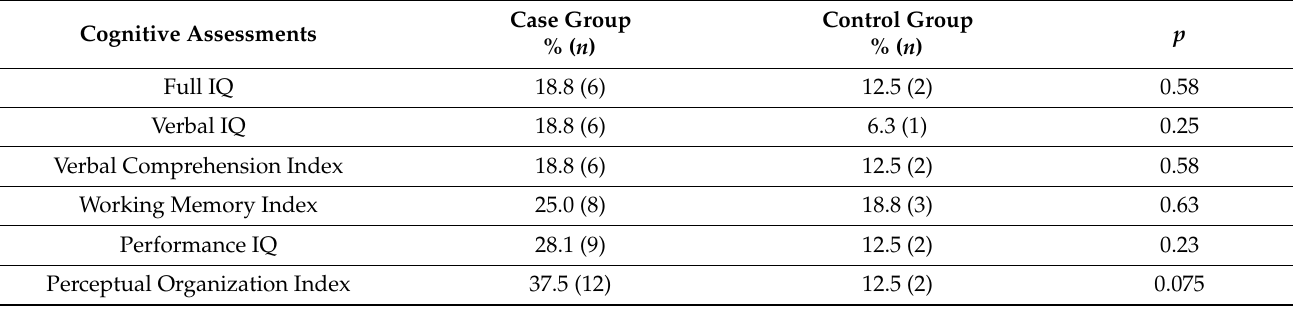
Table 5. IQ scores of 85 or lower at an early school age.